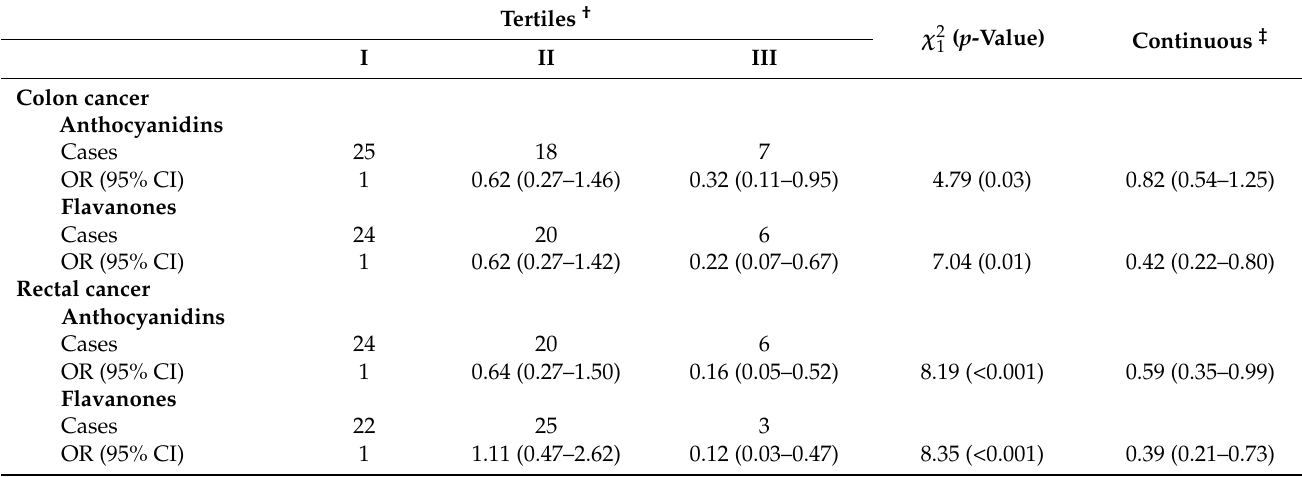
Table 3. Odds ratios (OR) * of colon cancer and rectal cancer and 95% confidence intervals (CI) among 50 colon and 50 rectal cancer cases and 200 controls. Italy